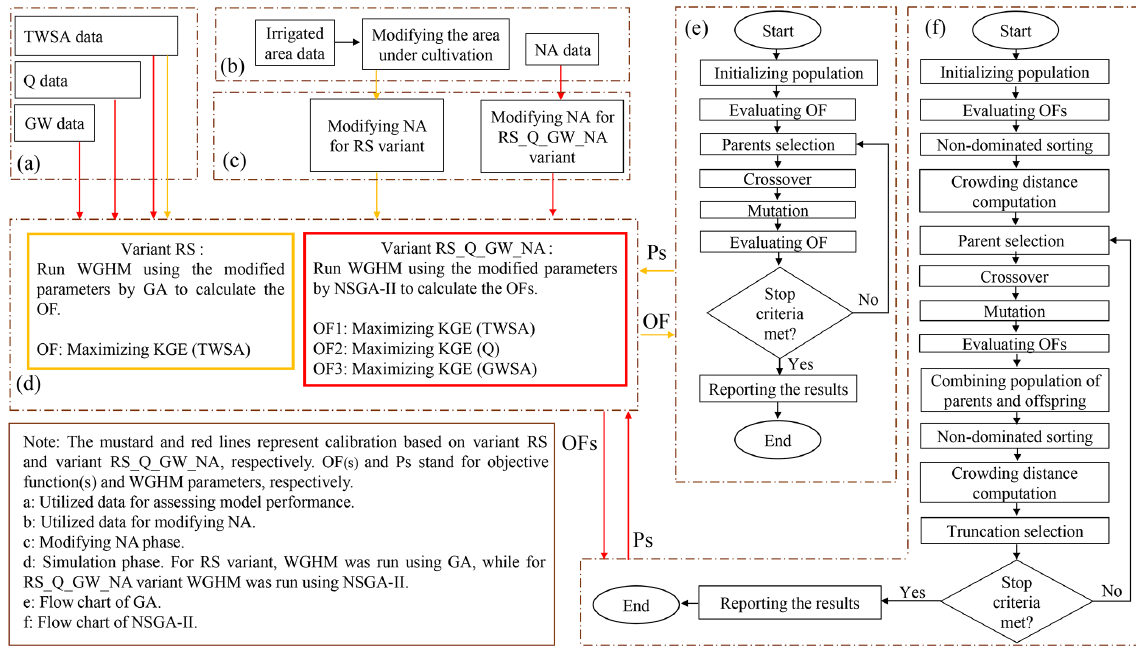
Figure 4. Flowchart of the WGHM calibration